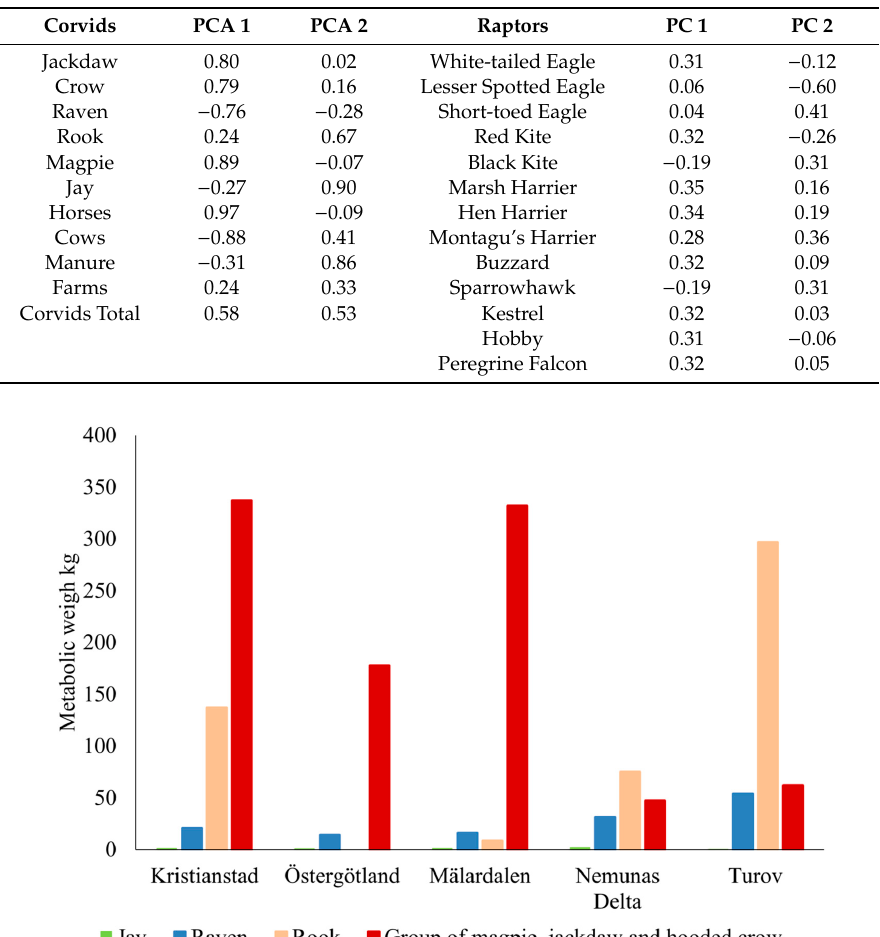
Figure 5. PCAs of 5 case study landscapes by corvid birds and resources availability (left) and landcover strata by raptor species (right). The landcover strata correspond as: Urban area (URB), agricultural land (AG) (forest cover <5%), semi-natural grassland, (GRASS) sparse forest (LOWF) (cover 5–20%), mixed forest and agricultural land (MIXF) (forest cover 40–60%) and high forest cover (HIGHF) (80–95%). Table 5. Left side of the table shows the loadings for the principal components 1 and 2 of the 5 case study landscape variables and corvids (Figure 5, Table 2; Table 3). Right side of the table shows the loadings for principal components 1 and 2 of the landcover strata variables and raptors (Figure 5).